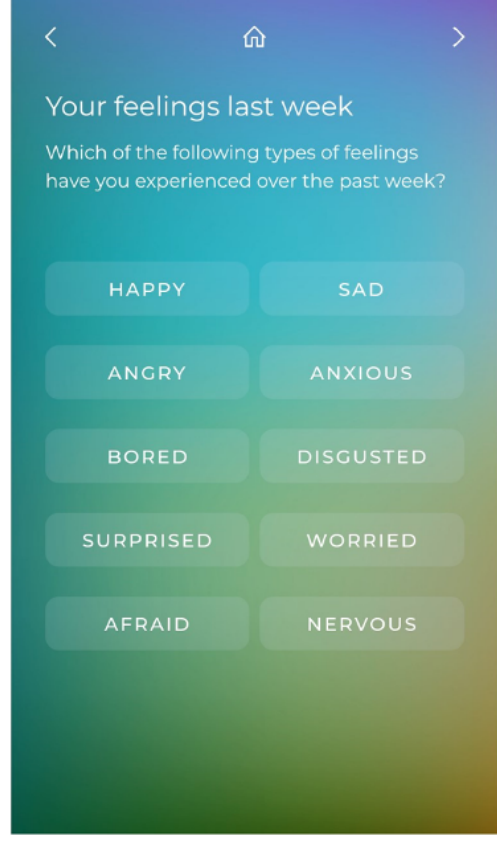
Completed Modules